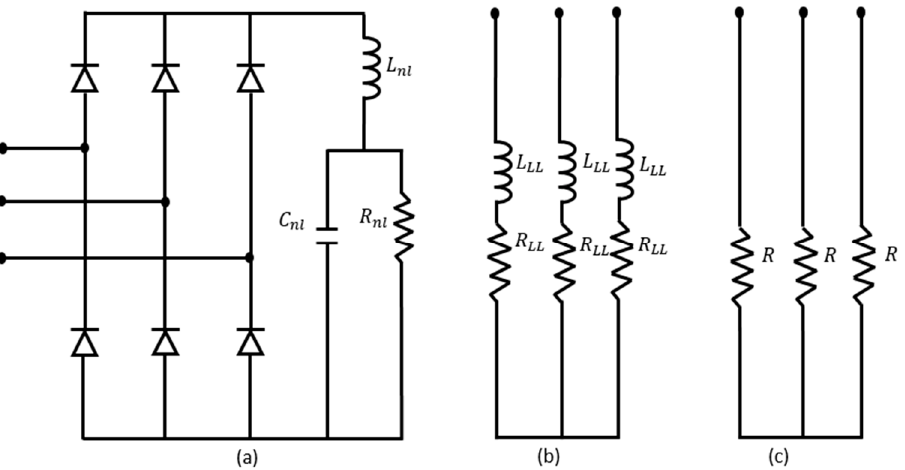
Figure 5. The three phases: ( a ) nonlinear, ( b ) inductive, and ( c ) resistive load models.